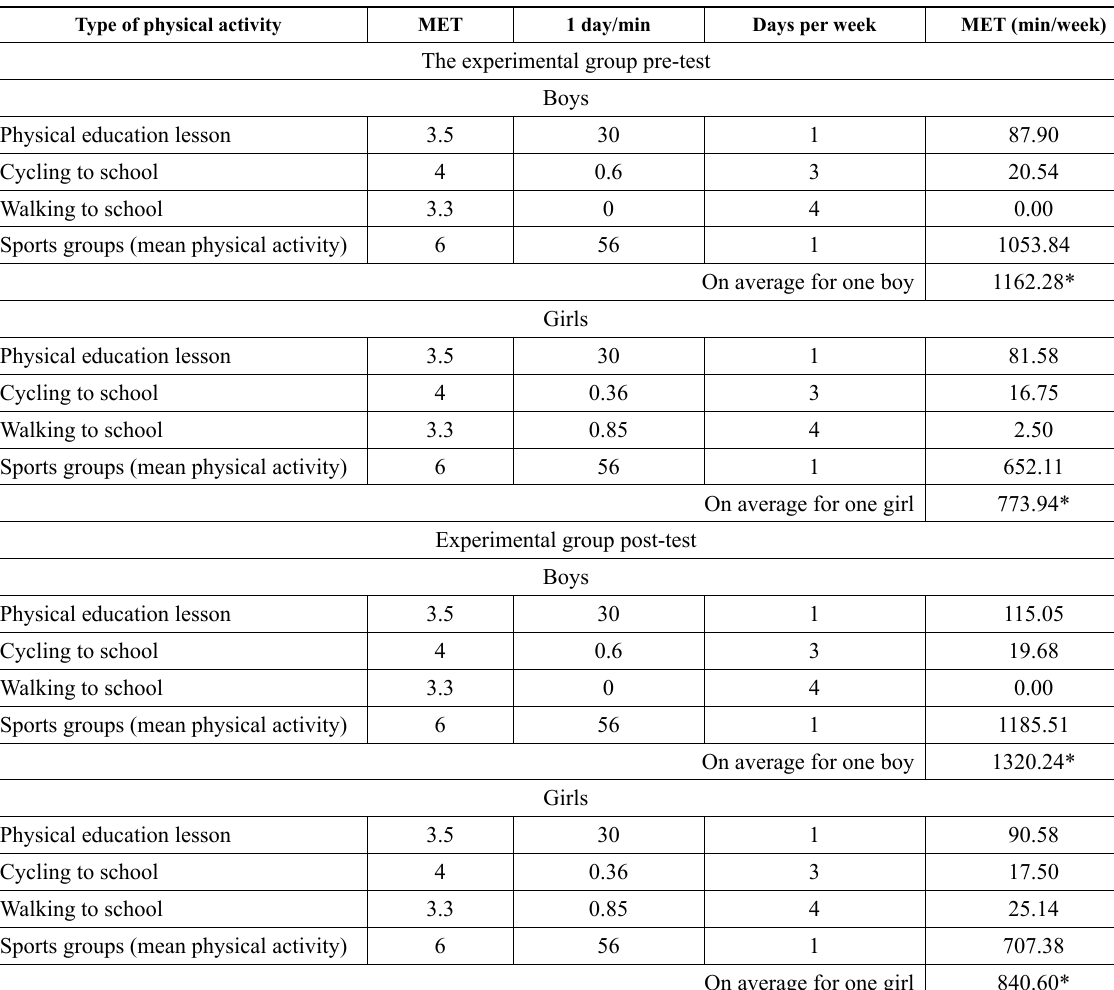
Table 1. Physical activity level using the MET method (the pre-test/post-test results of the experimental group)